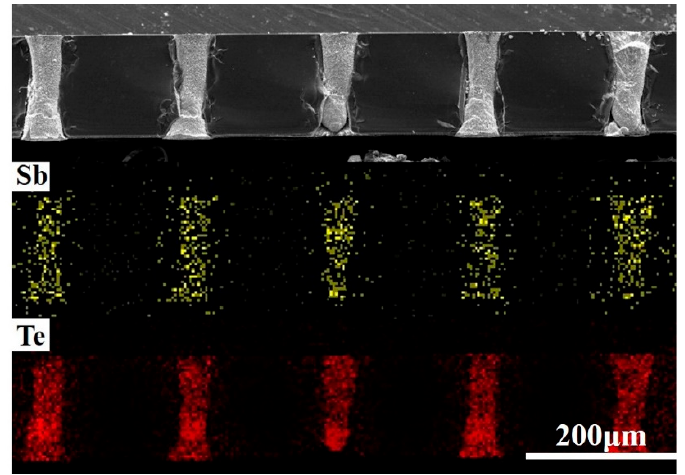
Figure 9. The elementary mappings of the Sb 2 Te 3 pillars.